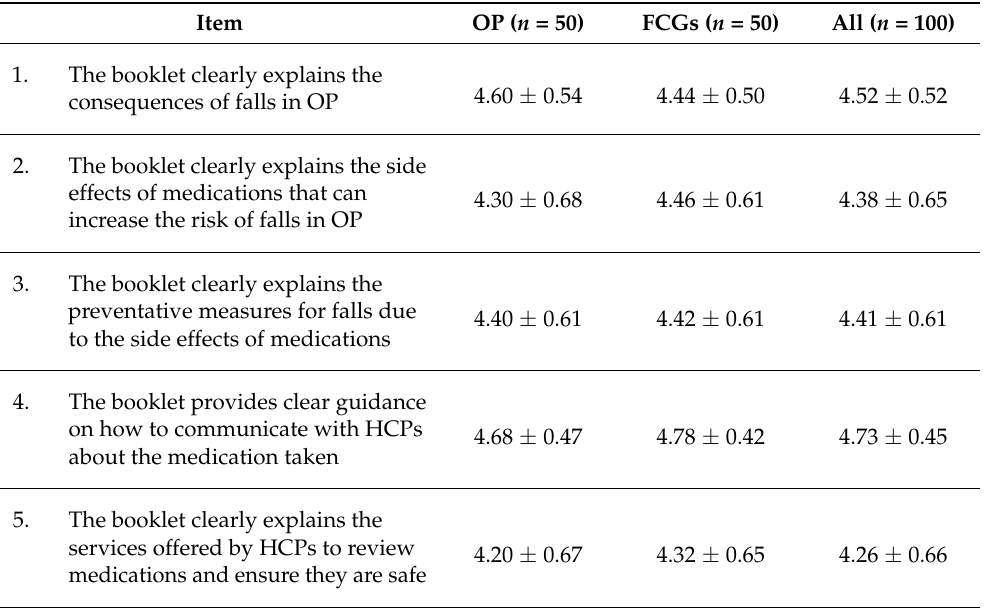
Table 6. Perceptions of the participants about the booklet’s usefulness (OP, n = 50 and FCGs, n =